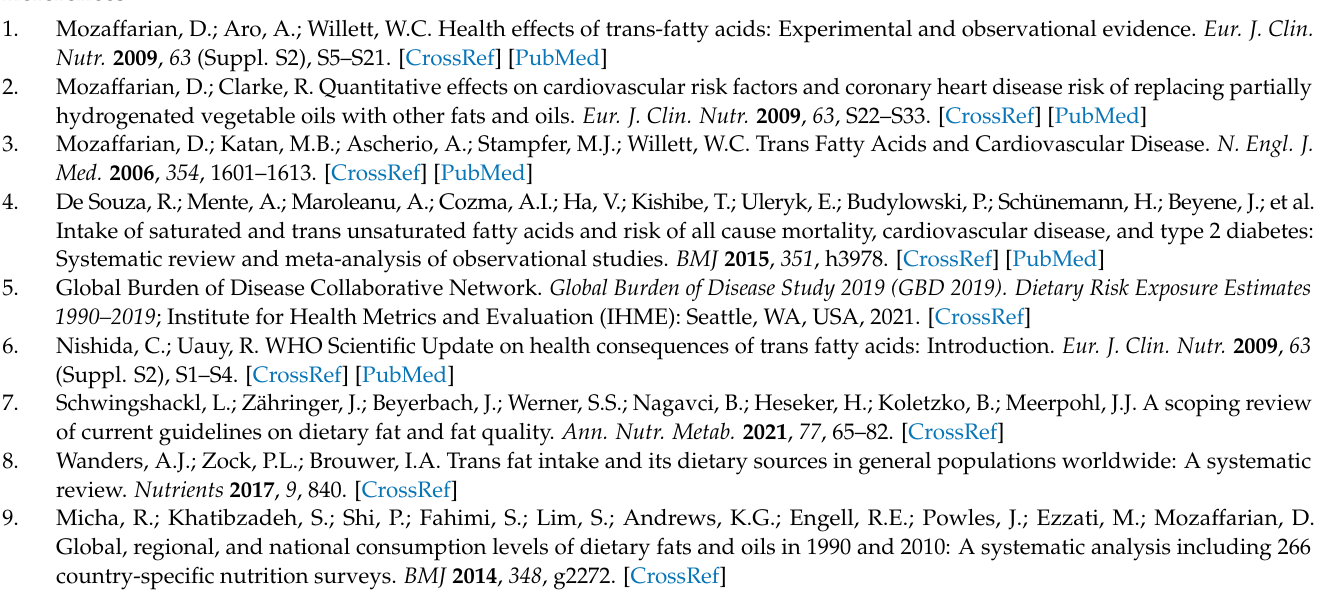
Table S2: Trans fatty acid concentration of two most commonly studied cooking oils (corn and soybean) and hydrogenated vegetable fat at predetermined temperature intervals; Table S3: Quality assessment of included studies; Table S4: Summary measures of cooking temperature, cooking time, and cooking cycle according to method of cooking; Table S5: Summary measures of cooking temperature, cooking time, and cooking cycle according to type of trans fatty acid; Table S6: Change in TFA content of cooking oils (% of total fatty acids) as a function of heating temperature; Table S7: Change in TFA as a function of the interaction between heating temperature and heating time (per 1 ◦ C